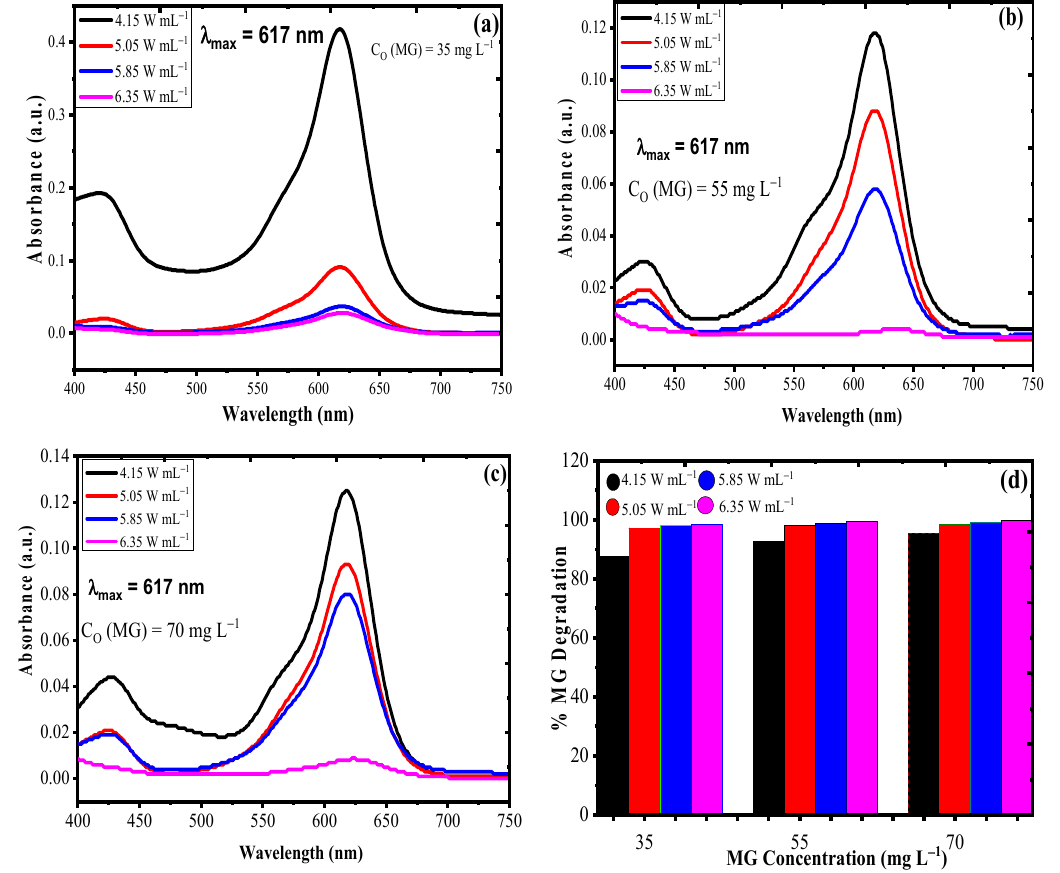
Figure 9. UV-Vis action curve for the effect of variable ultrasonication power density under visible irradiation for ( a ) 35 mg · L − 1 , ( b ) 55 mg · L − 1 , and ( c ) 70 mg · L − 1 MG concentration, and ( d ) percent MG degradation vs. MG concentration plot using 20 mg catalyst, pH 8, and 90-min irradiation time.